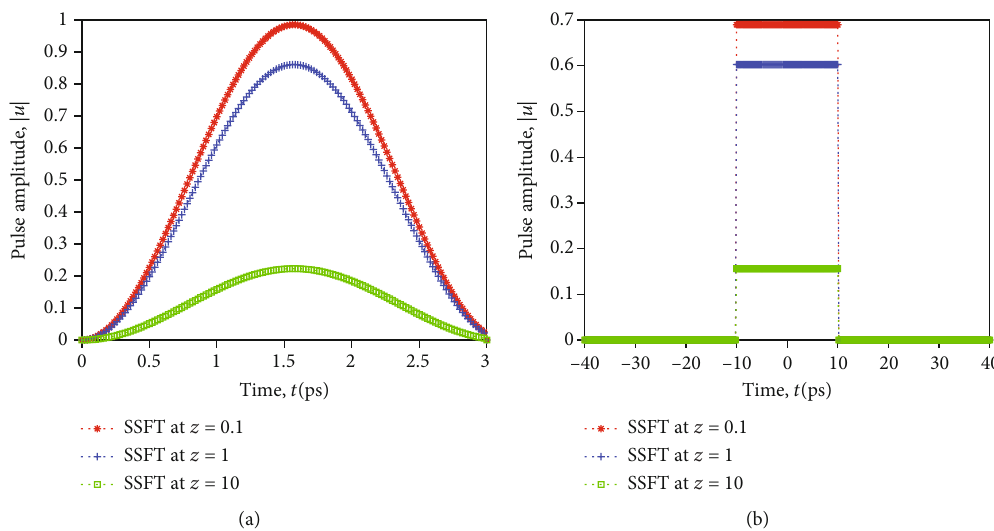
Figure 11: The split-step Fourier transform (SSFT) approximate solution for a lossy optical fi ber α = 0 : 3 dB/km when the input pulse is a sine squared function (a) and a rectangular pulse (b) at distances z = 0 : 1, 1, 10 km,